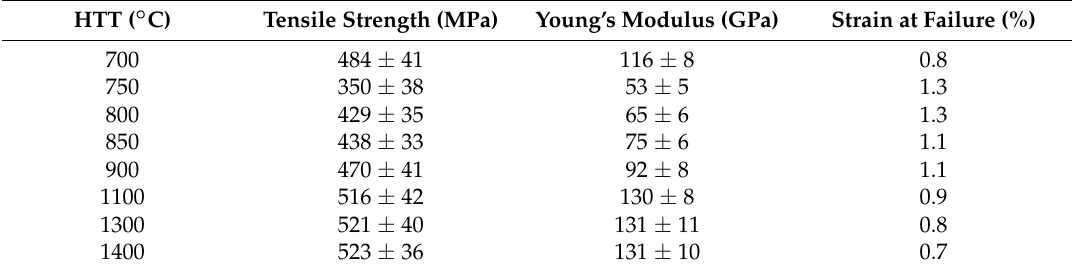
Table 1. Mechanical performance of each sample. Legend: HTT, heat treatment temperature. HTT ( ◦